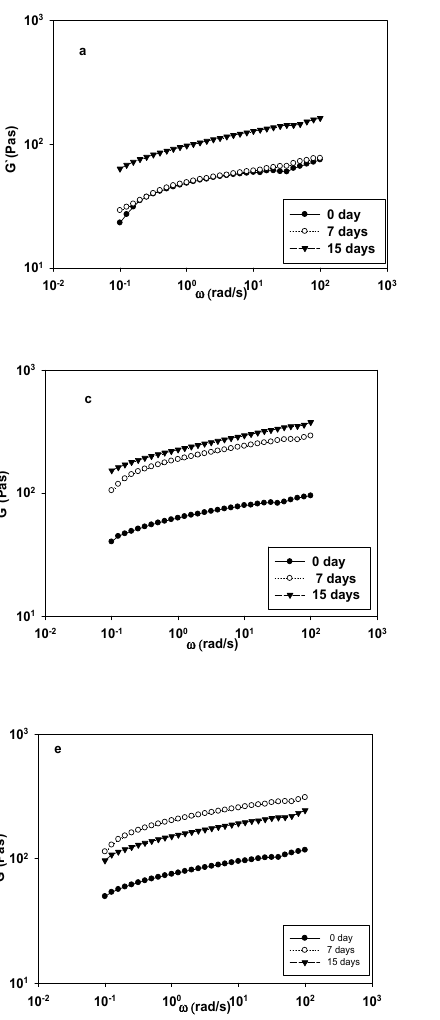
Figure 3. The G ′ of yoghurt samples fortified with starch and stored for 0, 7, and 15 days: ( a ) control, ( b ) chickpea, ( c ) corn, ( d ) potato, ( e ) sweet potato, and ( f ) Turkish beans starches.